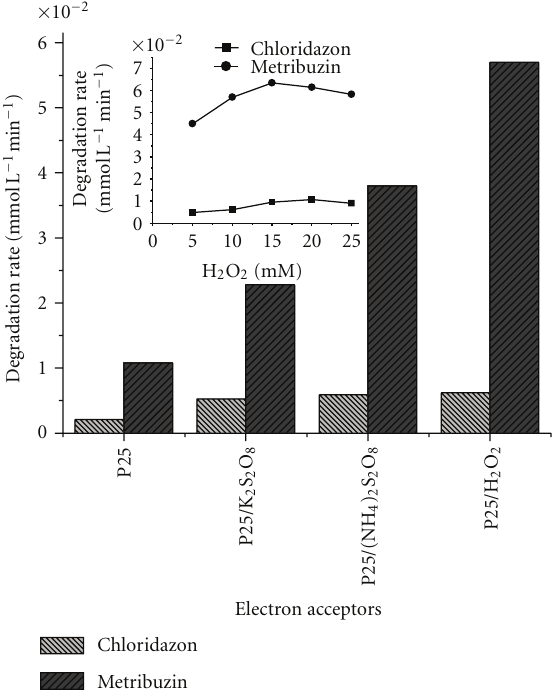
Figure 5: Influence of electron acceptors on the the degradation rate of CHL and MET. Experimental conditions : CHL (0.18mM), MET (0.30mM), electron acceptors, K 2 S 8 O 8 (3mM), (NH 4 ) 2 S 2 O 8 and H 2 O 2 (10mM), V = 125 mL, photocatalyst: TiO 2 Degussa P25 (1gL − 1 ), irradiation time: 60 min (CHL), 28min